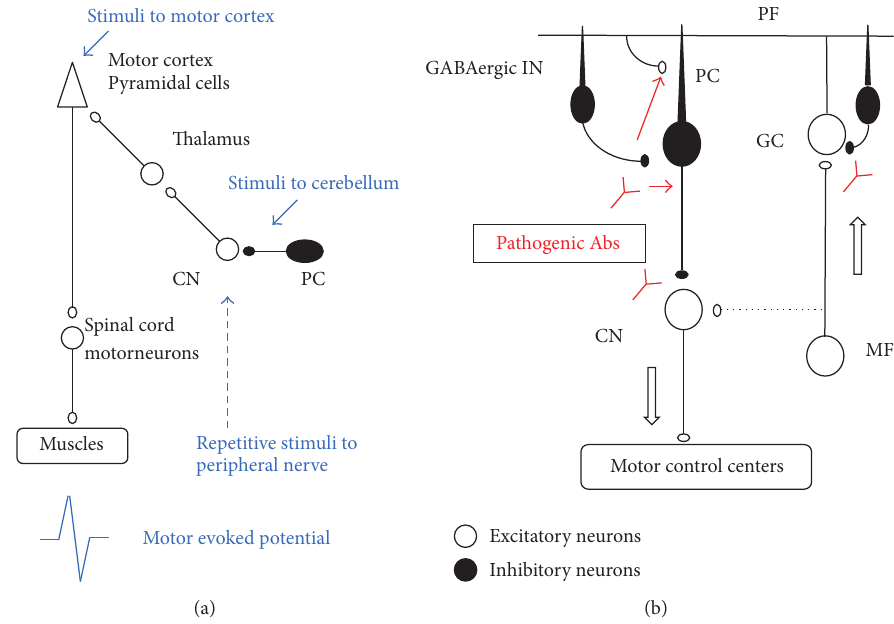
Figure 1: (a) Schematic diagram of electric stimulation experiment in vivo. (b) Schematic diagram of effects of GAD65Ab in the cerebellar circuit. PC: Purkinje cell, GC: granule cells, PF: parallel fiber, MF: mossy fiber, GABAergic IN: GABAergic interneuron, CN: Cerebellar nuclei. Arrows in (b) indicate the flow of signals in the cerebellar cortex. The CN neurons receive weak MF collaterals in the cerebrocerebellum and strong collaterals in other areas. Thus, the MF collateral is indicated by a dotted line. These figures were modified from our previous references [7, 30,